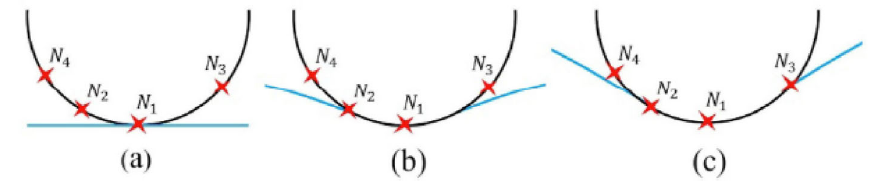
Fig. 61 Contact process of a rigid rough surface on an elastic half-space. (a) Before the load is applied, (b) two nodes in contact, and (c) three nodes in contact [881]. Reproduced with permission from Ref. [881], © The author(s),